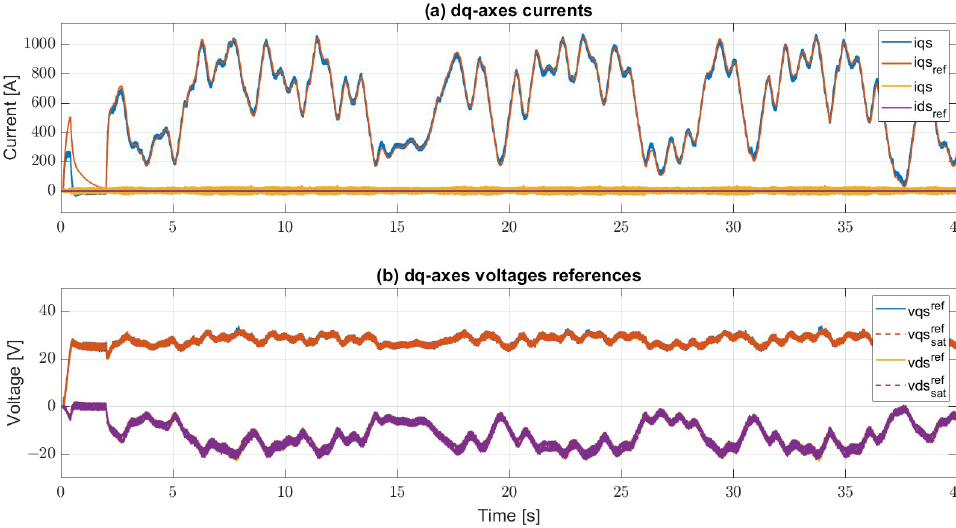
Figure 24. dq axes variables: ( a ) currents; ( b )